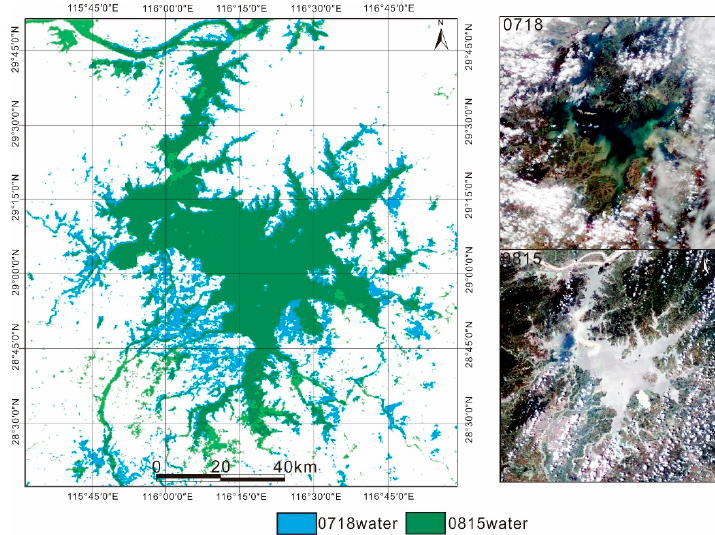
Figure 13. Water distribution in Poyang Lake region in July and August.